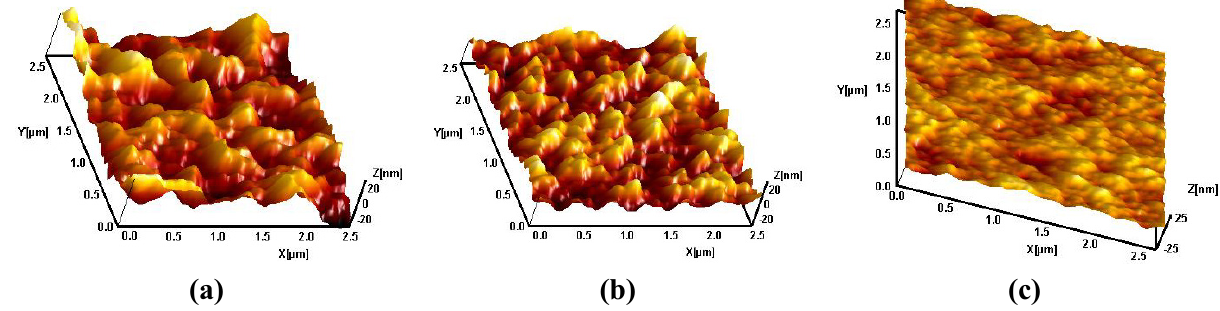
Figure 4. Atomic Force Microscopy (AFM) images of 7-layer ZnO thin films: ( a )